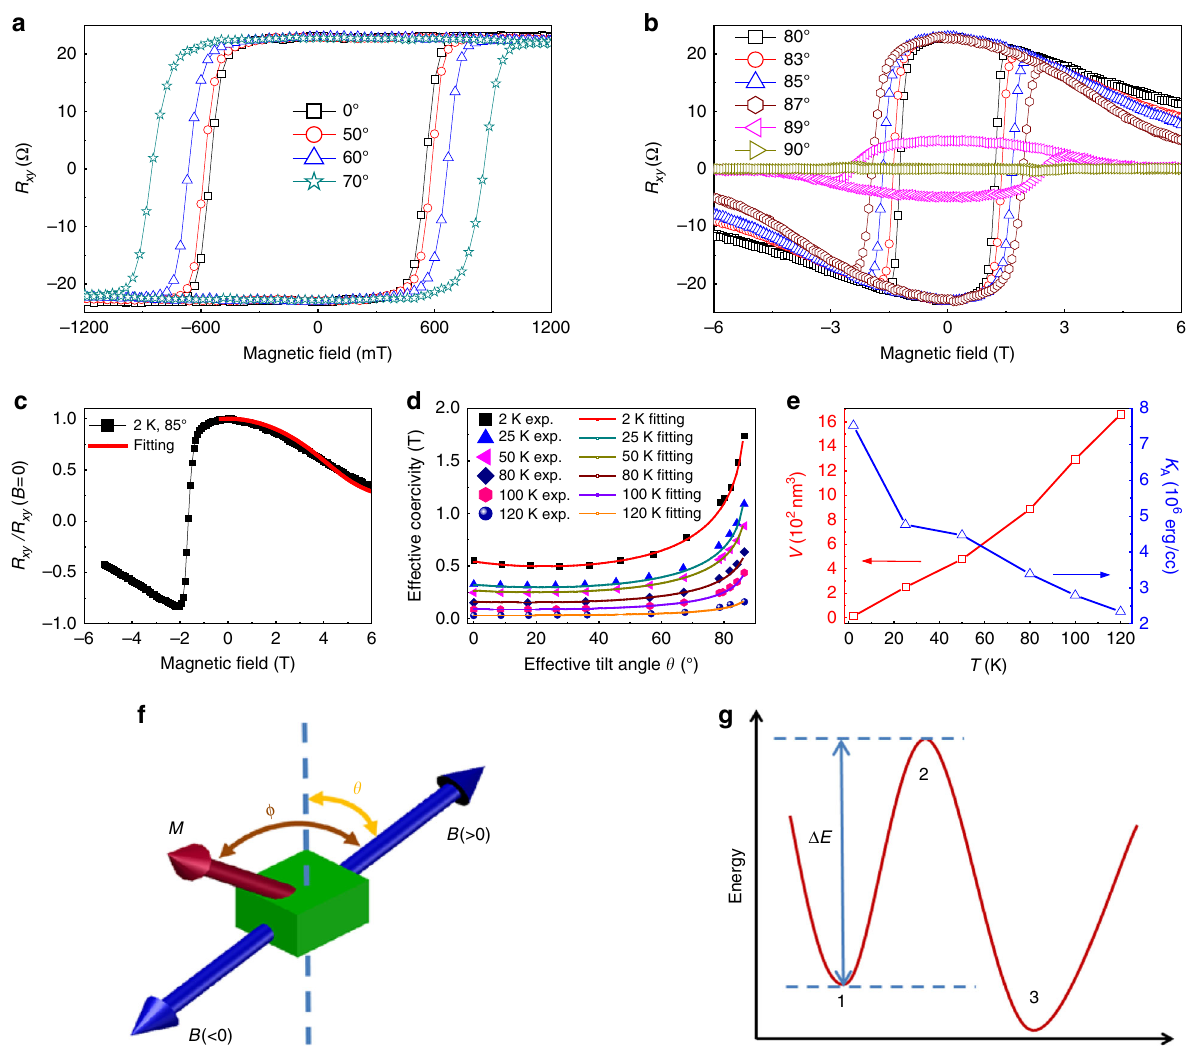
Fig. 4 Angular dependent Hall effect measurements and modi fi ed Stoner – Wohlfarth model. a , b R xy ( B ) loops at different angles between the applied magnetic fi eld and the direction perpendicular to the surface of the nano fl ake with a thickness of 10.4 nm. At 0°, the surface of the nano fl ake is perpendicular to the magnetic fi eld. c Normalized R xy ( B ) curve at 2 K measured at 85° from 6 to − 6 T. The fi tting curve is based on the Stoner – Wohlfarth model. d The effective angular dependence of effective coercivities at different temperatures. The solid curves are the fi tting curves based on a modi fi ed Stoner – Wohlfarth model. From b we can tell that the remanences of the R xy loops at angles >85° show pronounced decreases and a divergent coercivity value was obtained at 90°, an angle beyond the range included by the modi fi ed Stoner – Wohlfarth model. Based on this experimental result, the theoretical fi ttings were only performed to 85°. e The temperature dependence of K V . K fi tted by the Stoner – Wohlfarth model, while V was fi tted based on A and A was the fi tted K A and the modi fi ed Stoner – Wohlfarth model (Supplementary Note 4). f Illustration of the variables used in the Stoner – Wohlfarth model. The dashed line is the easy axis of the magnetic anisotropy in FGT nano fl akes. g Schematic diagram of a magnetic system changing from a metastable to